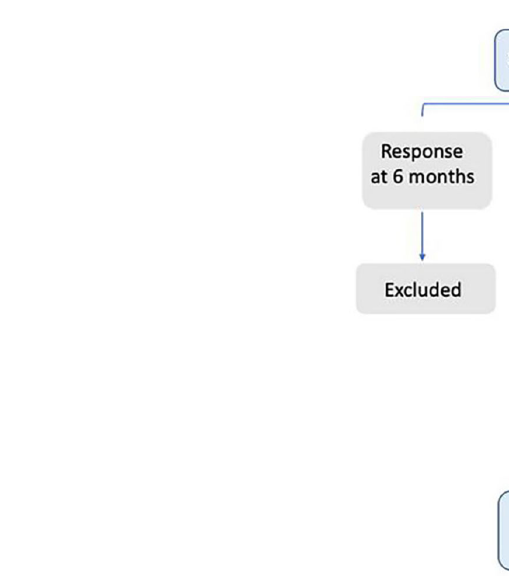
FIGURE 1 Process of the